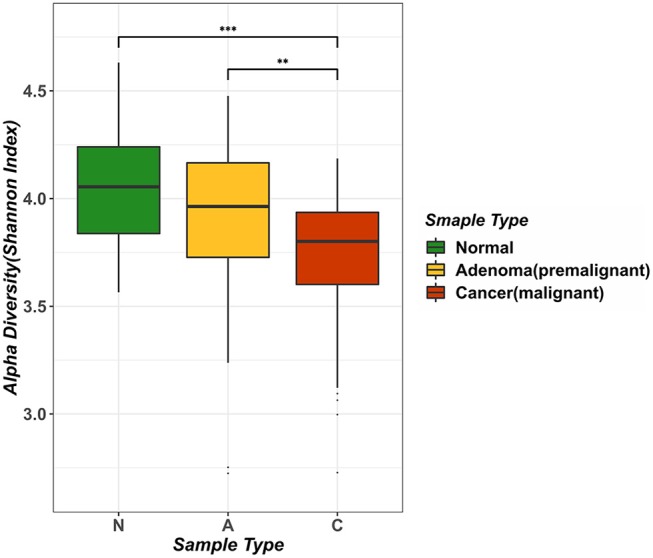
Analysis of intestinal microbial diversity in different environments. The three colors in the figure indicate the microbial diversity in different states: green represents the healthy samples, yellow represents adenoma (precancerous lesion) growth in the intestine, and red represents a sample of colorectal cancer patients. The average value of Alpha diversity of healthy samples was 4.0456, whereas the counterpart in the adenoma sample was 3.8957, and that in the cancer sample was 3.7161.